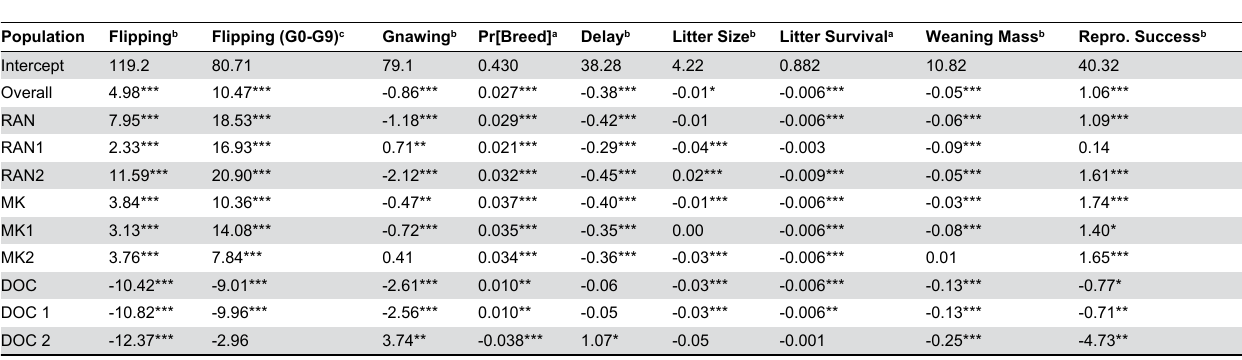
Asterisks indicate statistical significance: *P < 0.05; **P < 0.01; ***P < 0.001. a For dichotomous variables (Pr[Breed] and Litter Survival) effects are expressed as derivatives of the change from logistic regressions, with the effect being the difference between the predicted value for G1 and G0. b For continuous variables, effects are the slopes from linear regressions. c For Flipping behavior, regressions are reported across both the full 18 generations and for the first 9 generations, during which the DOC 2 population persisted and over which most of the change in Flipping occurred in all populations.